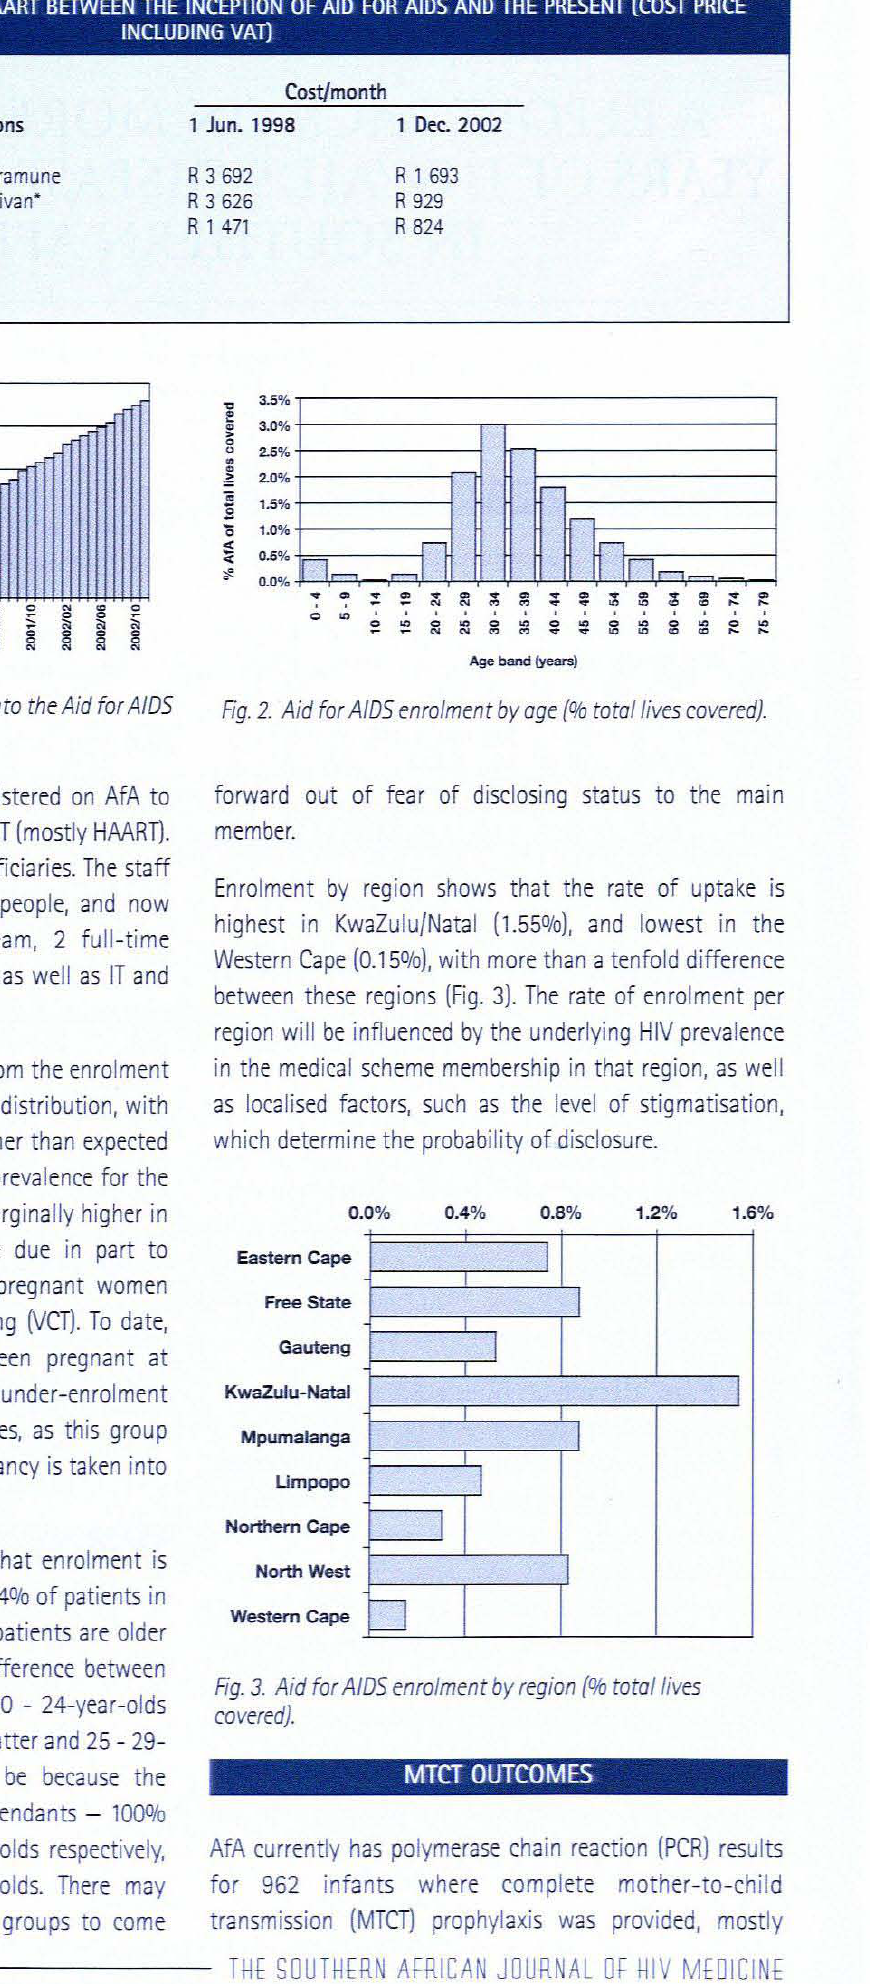
TABLE I. CHANGE IN THE COST OF HAART BETWEEN THE INCEPTION OF AlO FOR AIDS AND THE PRESENT (COST PRICE INCLUDING VAn